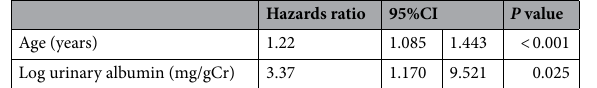
Table 2. Multivariable Predictors of MACCE in Diabetic Patients with